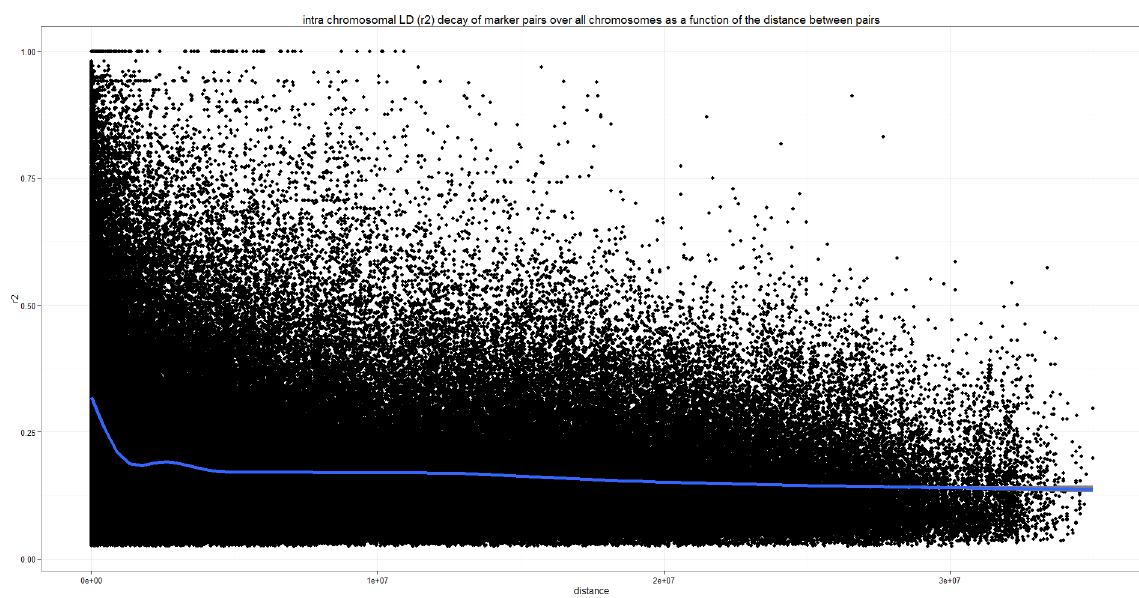
LD decay curve fitted by the GAM function is represented by the blue line.